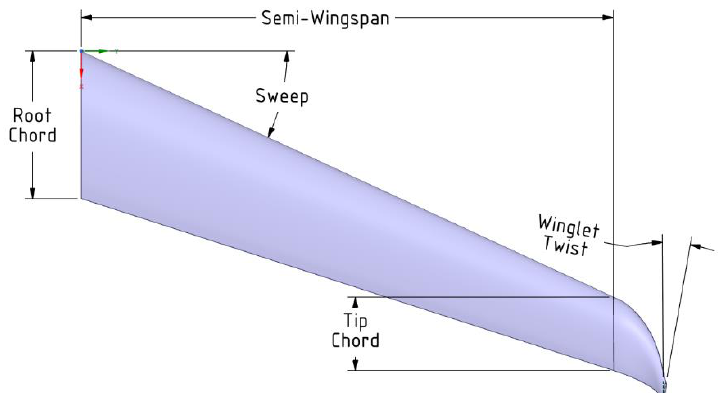
Figure 2. Top view of the designed wing with the winglet. Table 1. Features of the designed wing.